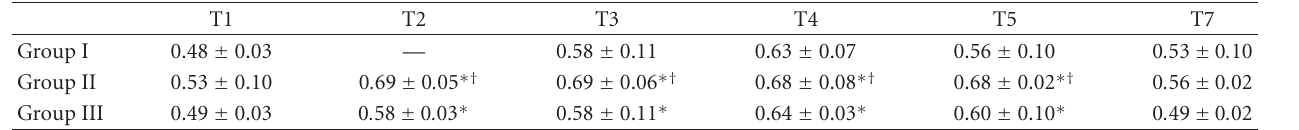
Table 6: Renal resistive index values obtained thorough the